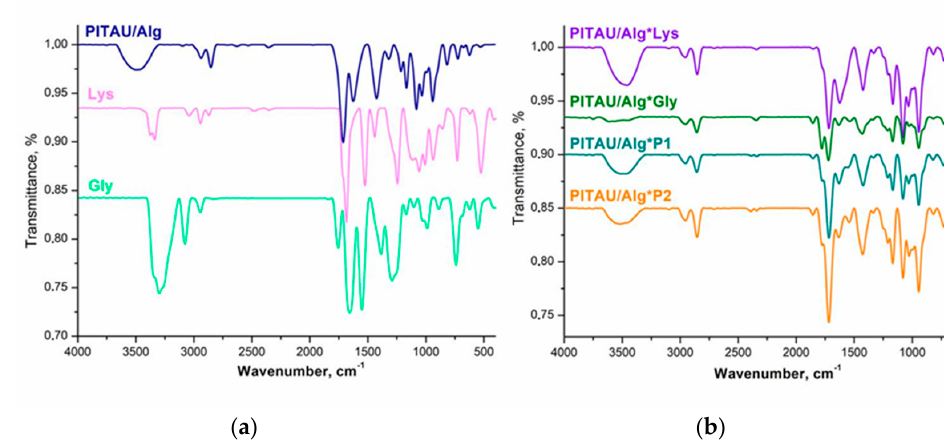
Figure 2. FTIR spectra of ( a ) PITAU/Alg, Lys, Gly and ( b ) the synthesized DN hydrogels. In brief, the synthetic copolymer's characteristic bands are at 1780 cm − 1 and 1856 cm − 1 for the C=O symmetric and asymmetric stretching of the anhydride unit, 1660 cm − 1 corresponding to C=C stretching, 1400 cm − 1 attributed to =CH 2 in plane